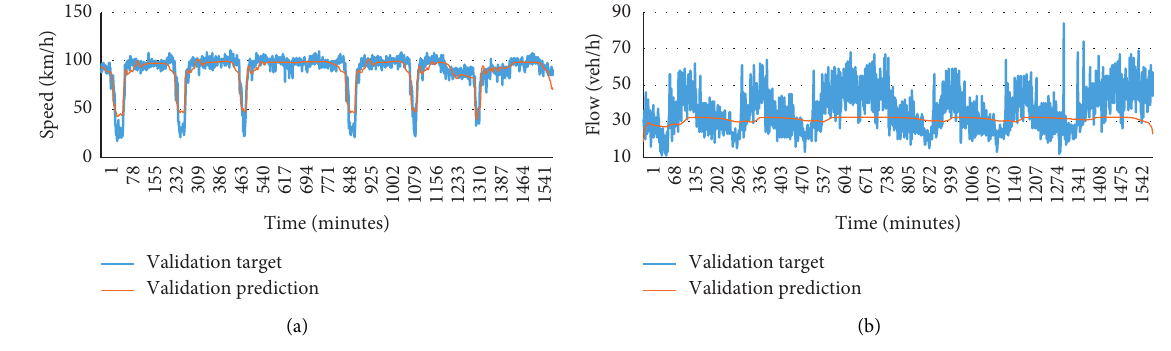
Figure 16: Speed and flow validation results for 60